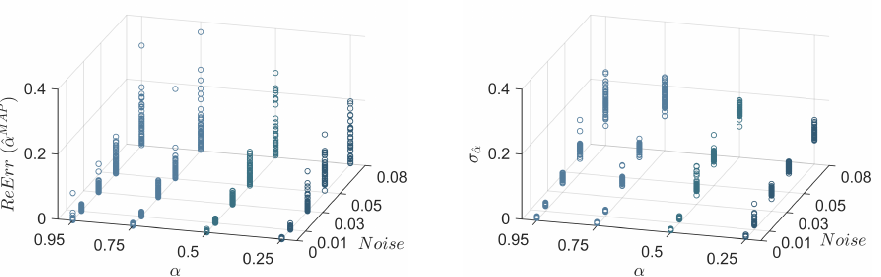
Figure 10. Box-plot of the reconstructed error (ReErr) of the identified damage location ˆ ϑ , classified based on the distances between sensors d sn : the MAP values ˆ ϑ MAP ( left ); and the standard deviation σ ˆ ( right ). ϑ